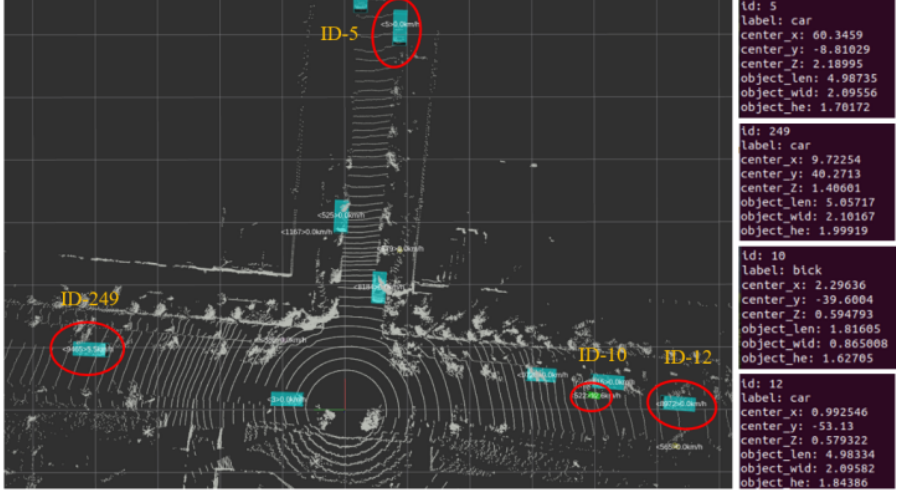
Figure 9. Visualized output of roadside platform perception results.